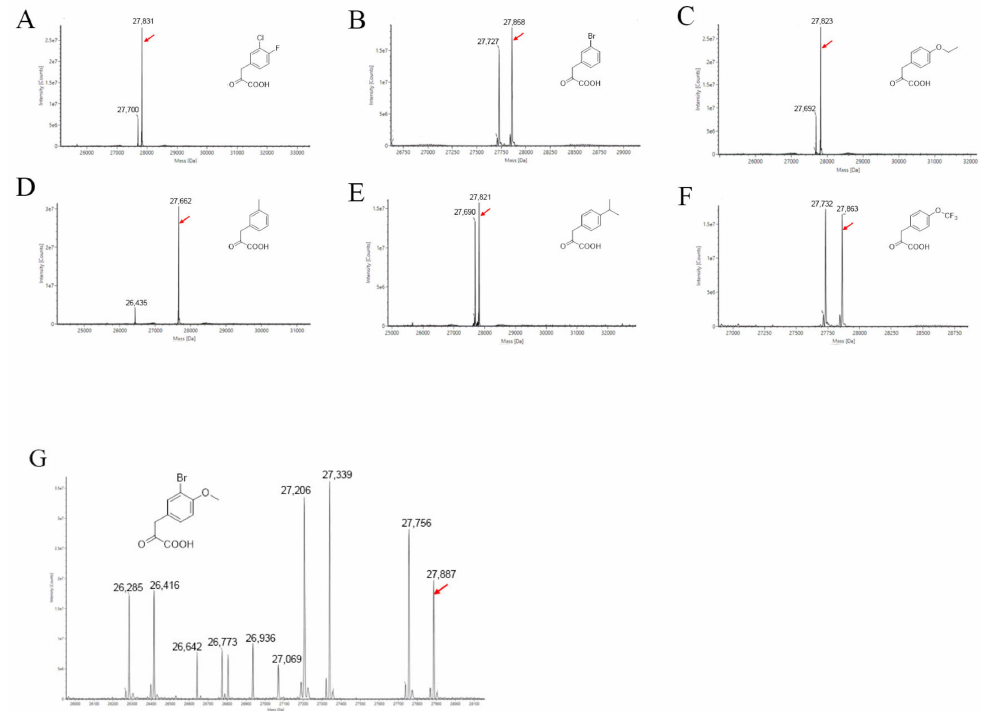
Figure 5. Electrospray ionization mass spectrometry of the eGFPs obtained from E. coli DH10B supplemented with the different keto acids. ( A ) eGFP produced with keto acid #2 resulted in a determined MW of 27,831, close to the theoretical MW of 27,831.7. Likewise, #3 ( B ) had a MW of 27,858 (theoretical 27,858.2); #4 ( C ) had a MW of 27,823 (theoretical 27823.3); #5 ( D ) had a MW of 27662, this GFP lacks Met (theoretical 27,793.3); #6 ( E ) had a MW of 27,821 (theoretical 27,821.4); #7